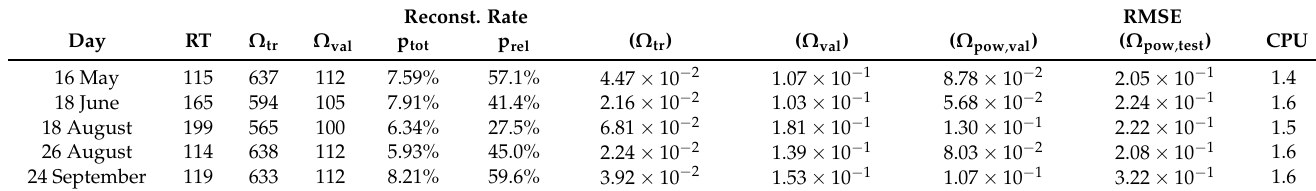
Table 2. Reconstruction results on days from the Sample_90 group. The reported statistics are averaged over 50 runs.